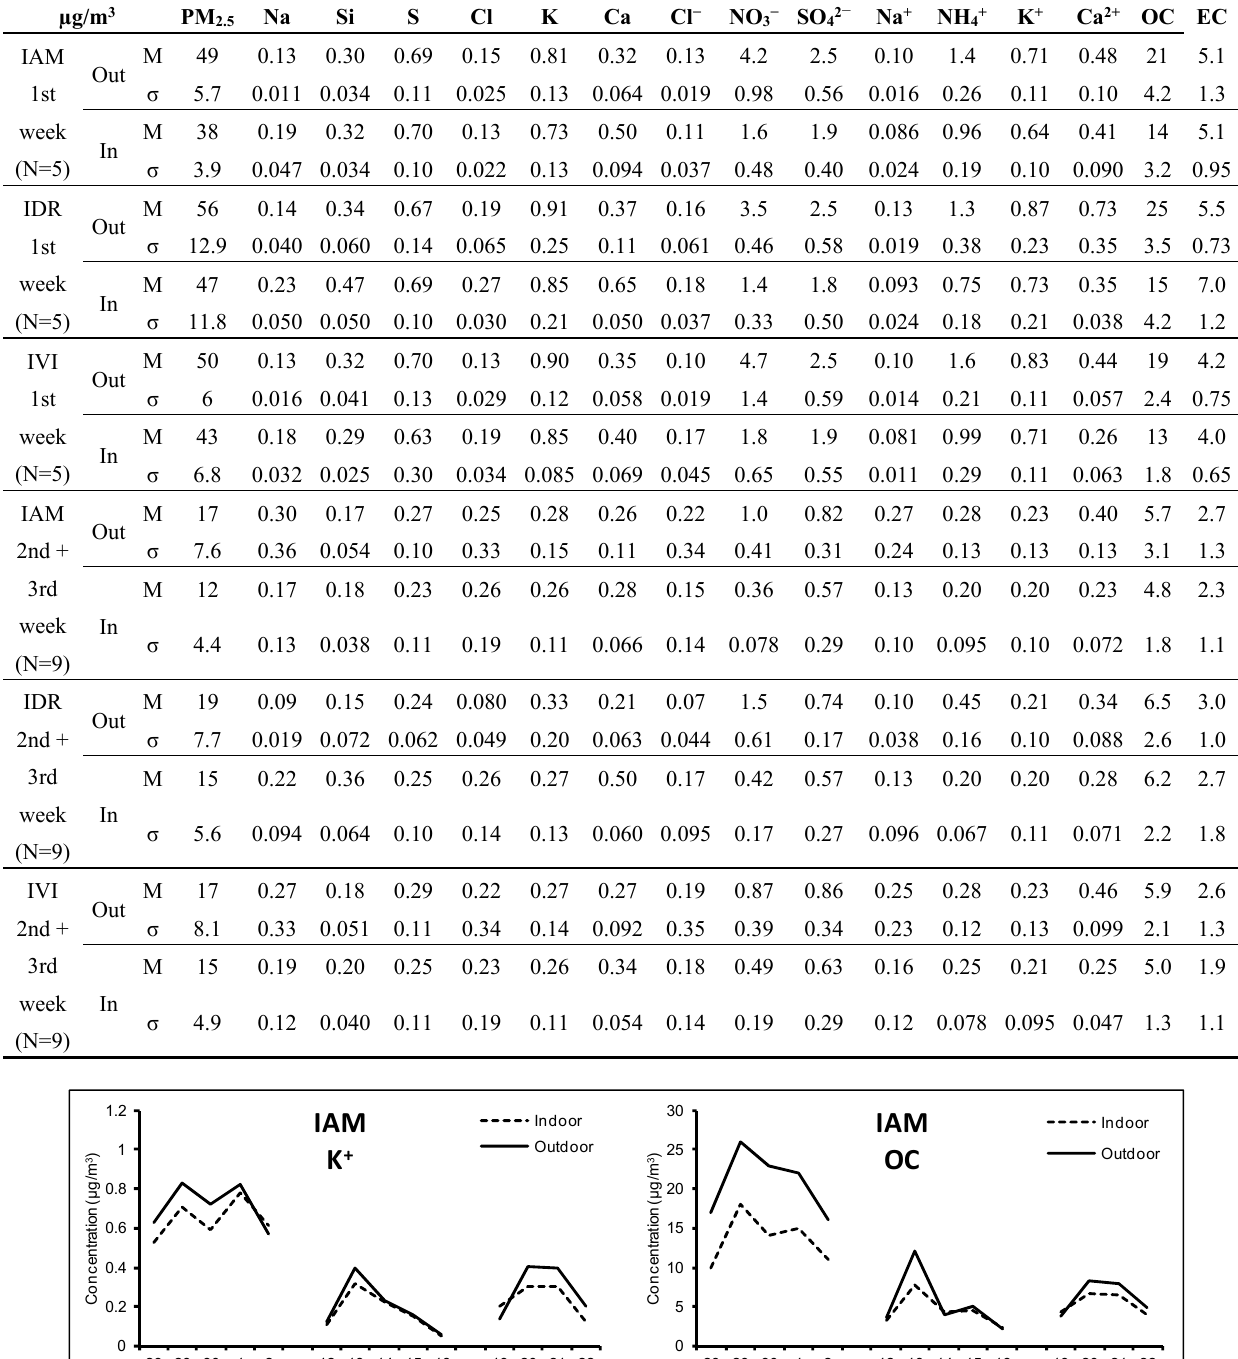
Table 1. Mean value (M) and standard deviation ( σ ) of the main chemical components measured indoor and outdoor during the winter period.